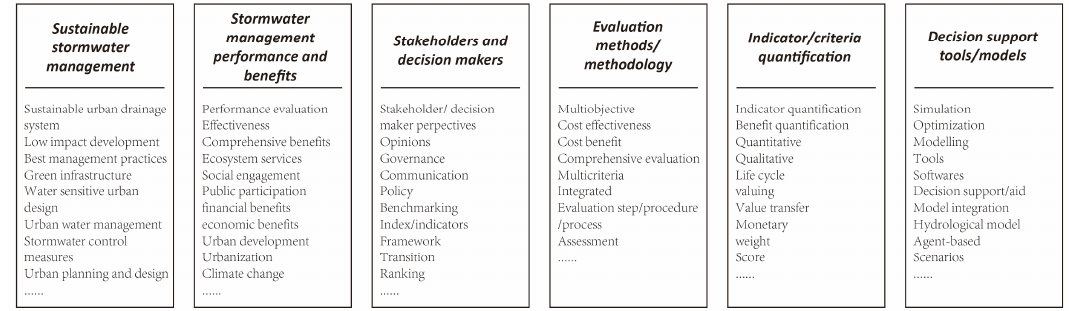
Figure 1. Key words of the literature search (overlaps may exist between each category box).